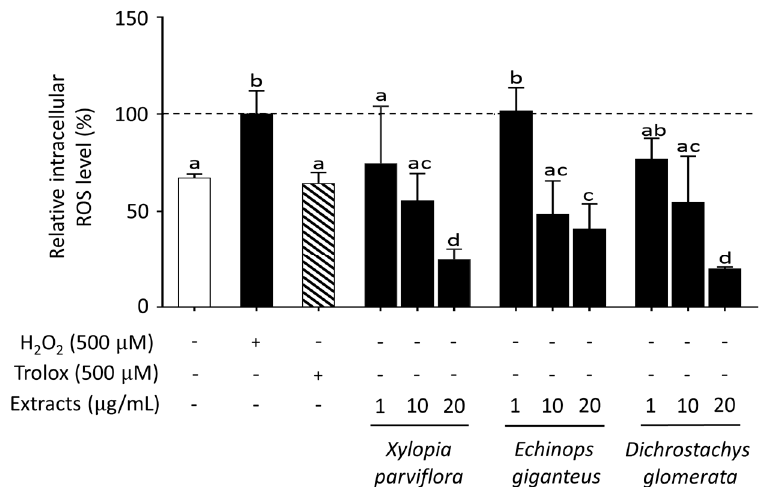
Figure 2. E ff ect of spice extracts on intracellular reactive oxygen species (ROS) production in HepG2